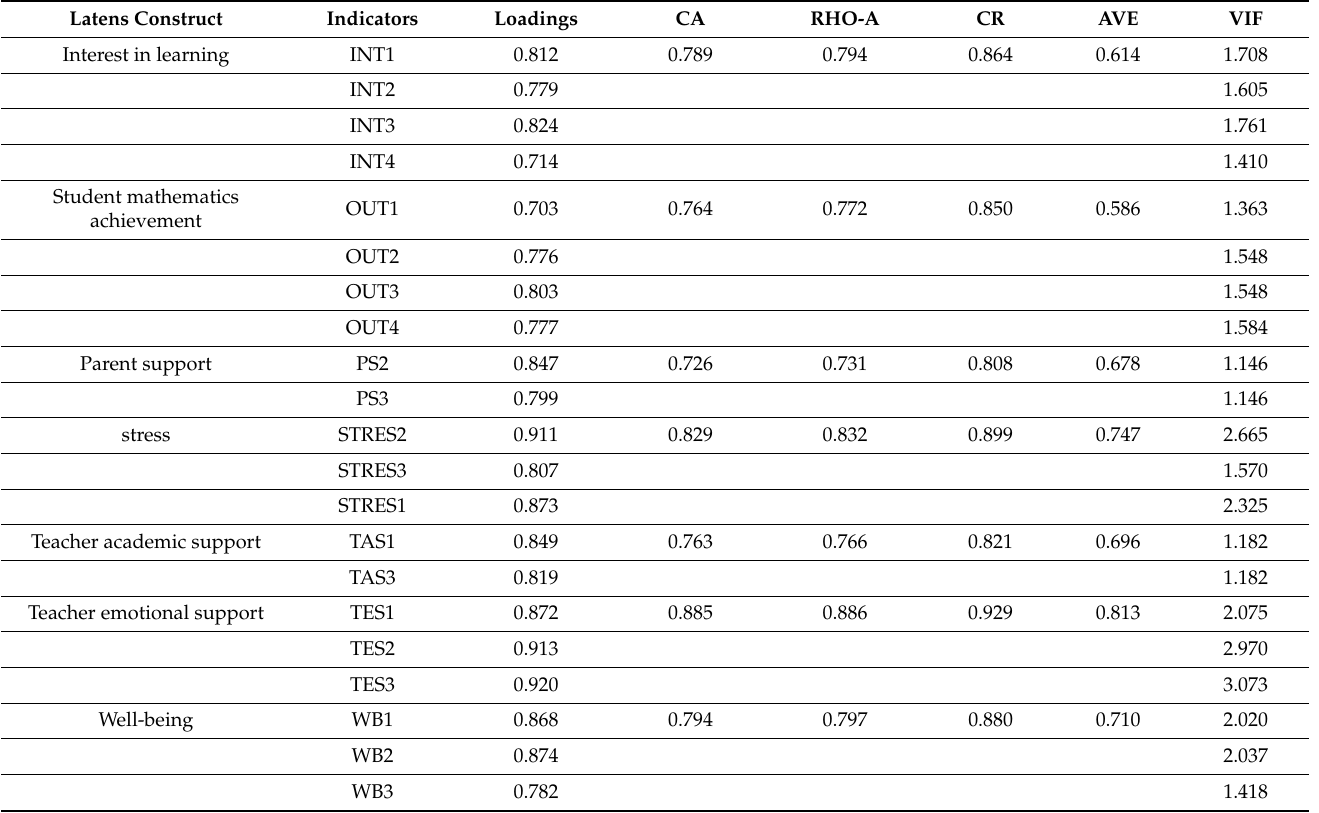
Table 3. Data for testing the measurement model and collinearity problems.